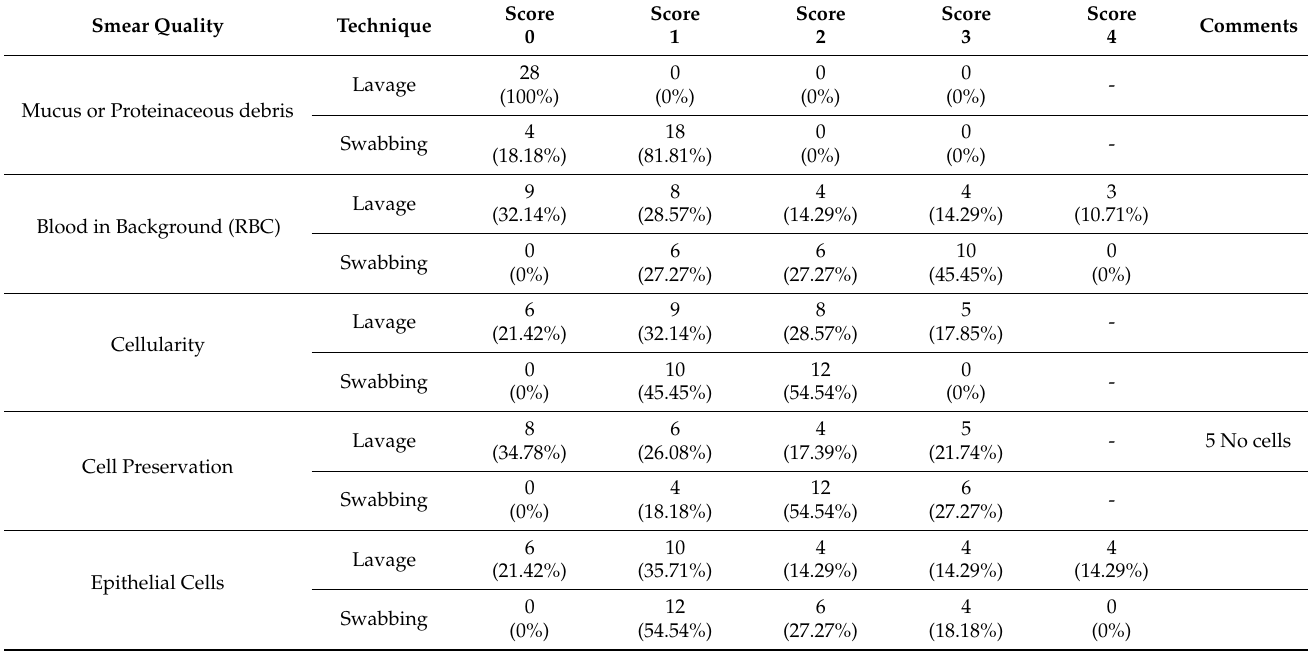
Table 5. Grading and distribution of the smear quality parameters according to the uterine sampling method. No statistically significant differences were observed for any of the evaluated